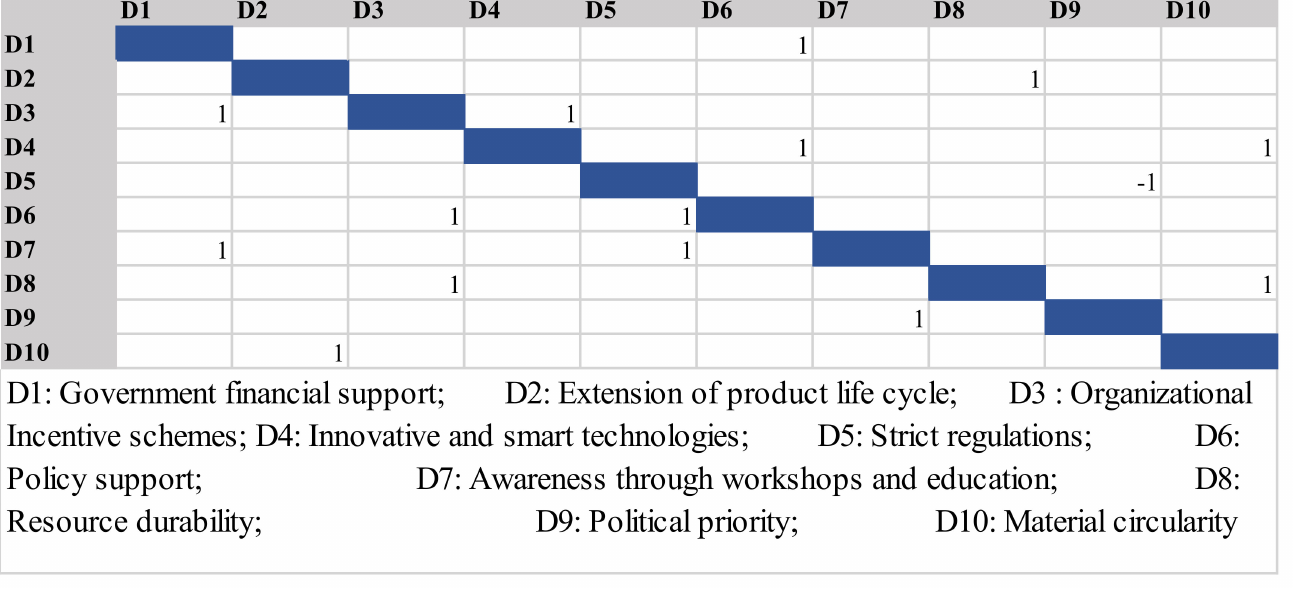
Figure 3. Influence Matrix.